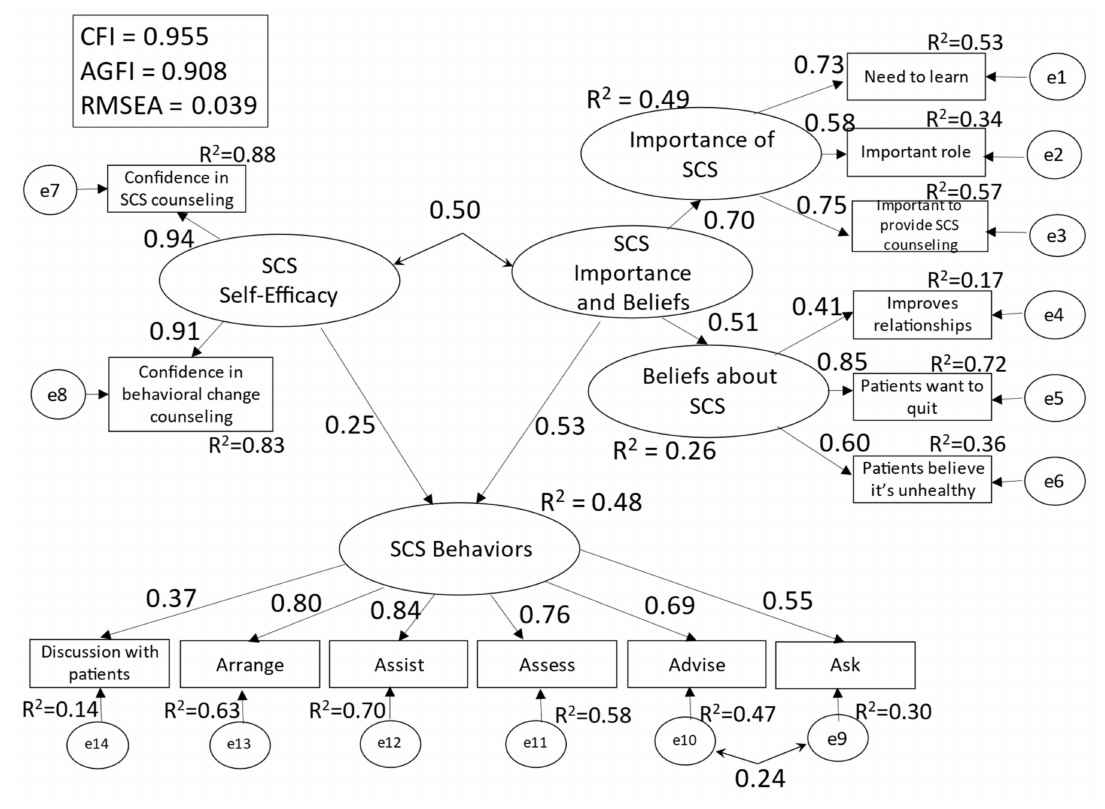
Figure 3. Conceptual Model 2 (SCS